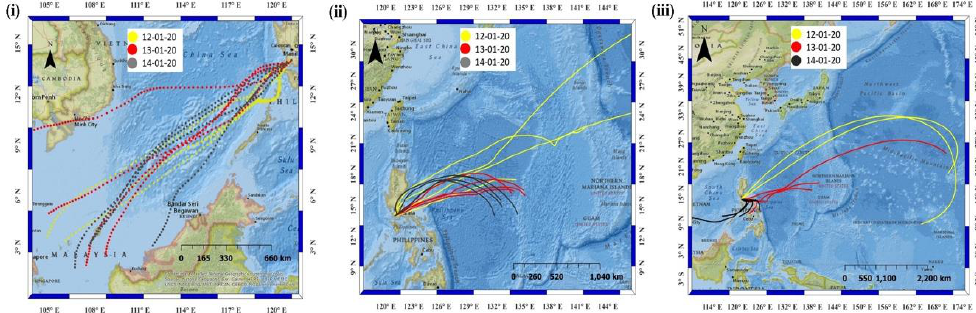
Figure 4. National Oceanic and Atmospheric Administration (NOAA) Hybrid Single Particle Lagrangian Integrated Trajectory (HYSPILT) forward trajectory at (i) 500, (ii) 5000, and (iii) 10,000 m heights, sourced from the Taal volcano for 150 h run time between 12 and 14 January 2020. The influence of the ash plume is seen over the south-west and north-eastern region from the Taal volcano from different heights and parts of Cambodia and Malaysia. (Source of the base map: National Geographic).